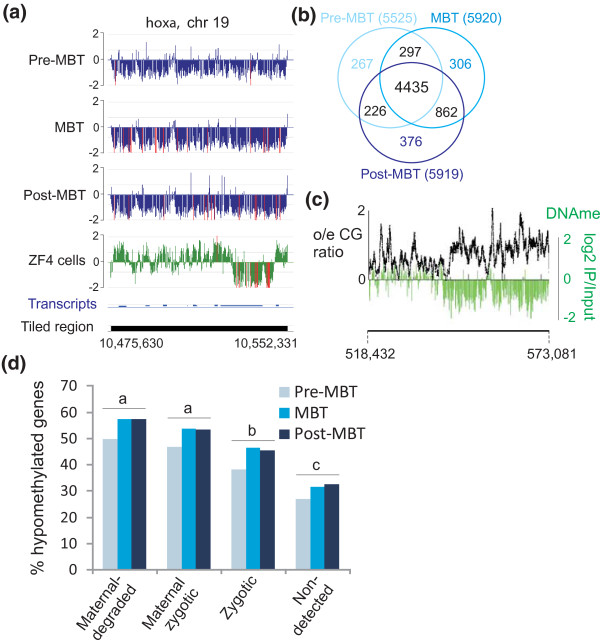
Maternal genes are preferentially hypomethylated relative to zygotic or non-expressed genes. (a) Hypomethylated domain over the hoxa locus in embryos and ZF4 cells. (b) Venn diagram analysis of hypomethylated genes at pre-MBT, MBT and post-MBT stages. (c) Domains of high o/e CG ratios exhibit hypomethylation, exemplified in a 51-kb region of chromosome 11 in pre-MBT embryos. (d) Proportions of hypomethylated genes in developmental gene cohorts. a,b/a,c/b,cP < 10-4 within developmental stage (Fisher).